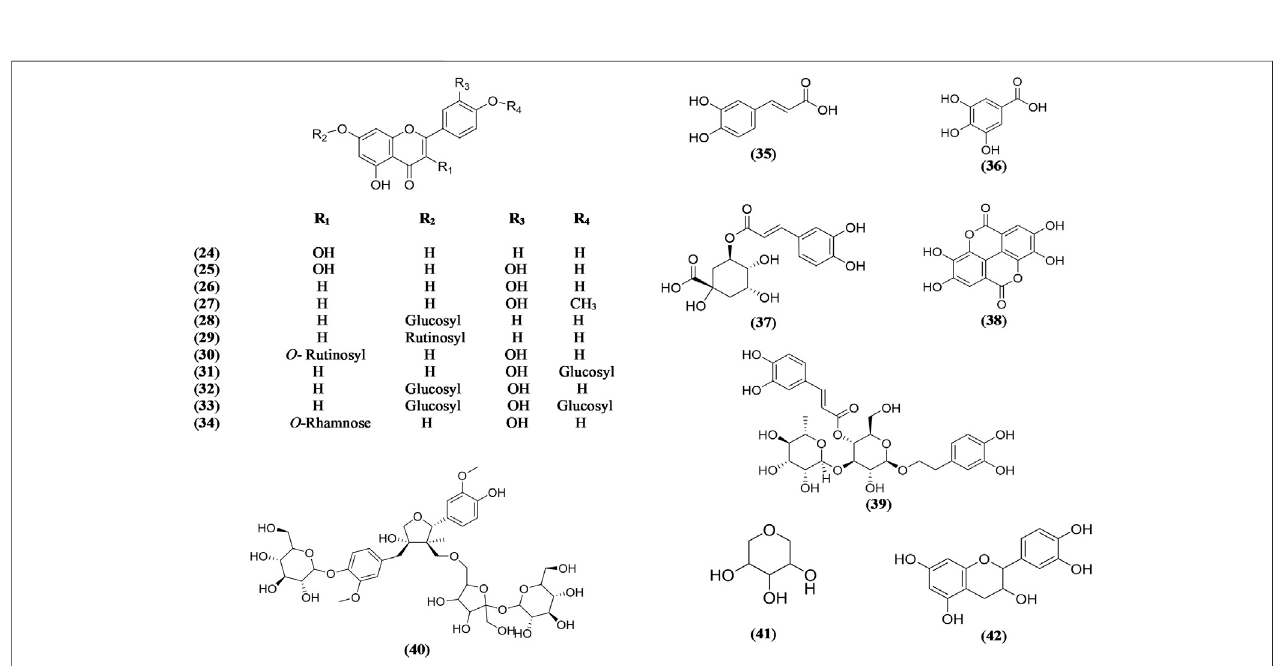
FIGURE 2 | Chemical structures of fl avonoids and phenolic compounds reported in Olea europaea leaves.